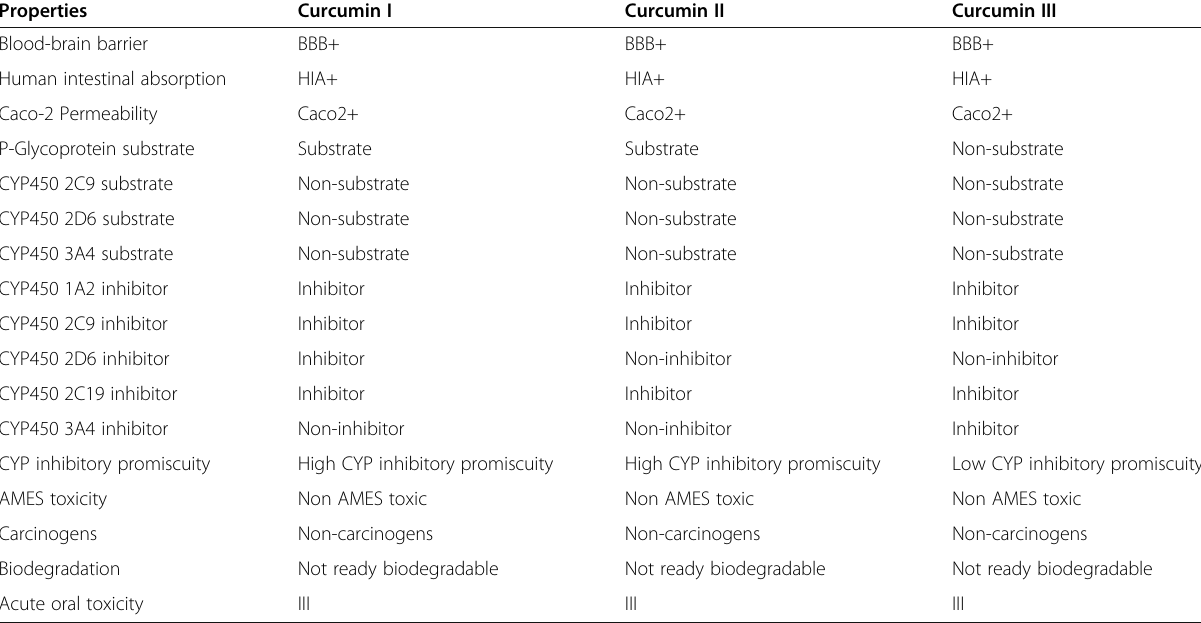
Table 3 ADME/T properties of curcumin I (PubChem CID: 969516), curcumin II (PubChem CID: 5469424) and curcumin III (PubChem CID: 5315472). BBB+: capable of penetrating the blood-brain barrier (BBB); HIA+: absorbed in human intestinal tissue;